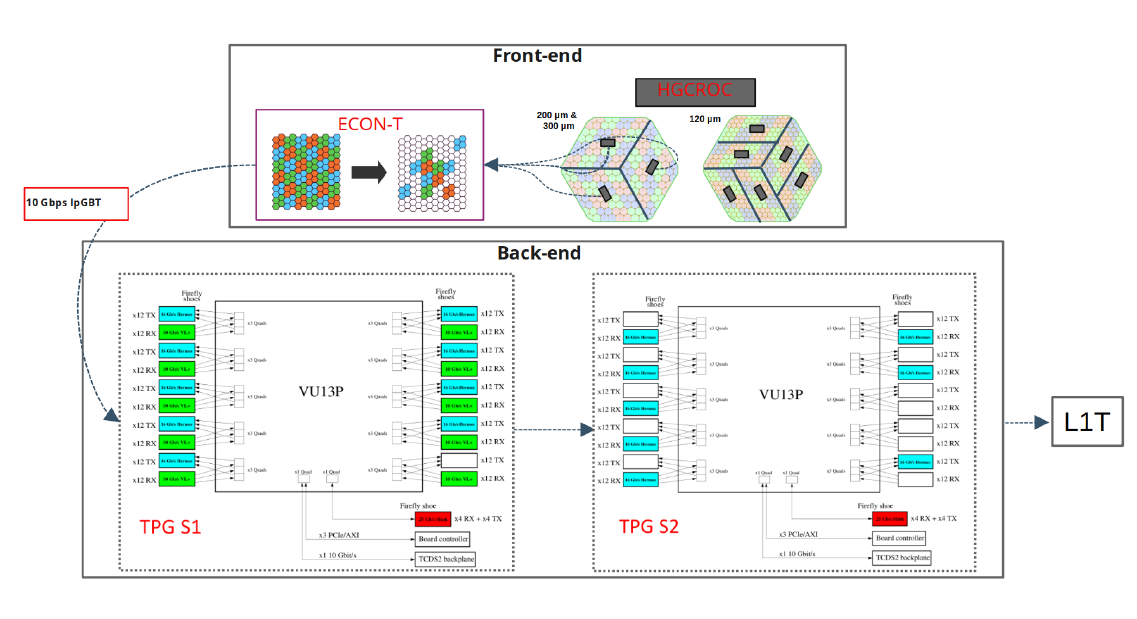
Figure 2. Schematic representation of the trigger primitive generation front-end and back-end hardware chain.